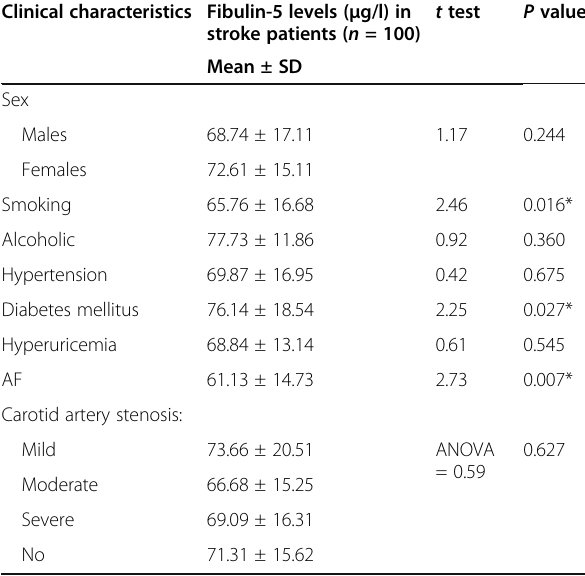
Table 4 Risk factors for fibulin-5 in stroke patients